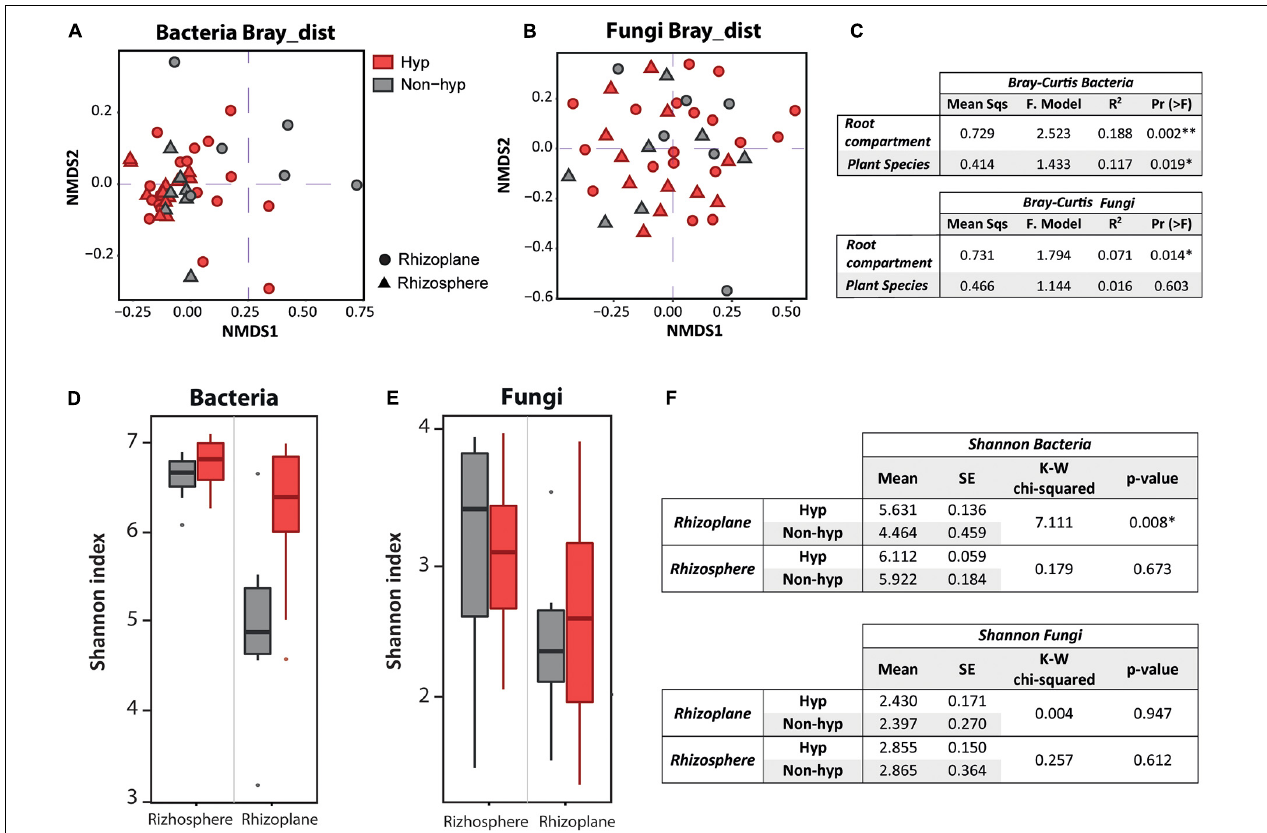
FIGURE 3 | Factors influencing the bacterial and fungal community and diversity. Non-metric multidimensional scaling visualization of the Bray–Curtis results of the bacterial domain (A) and fungal domain (B) . Plant species are differentiated by color (red is the hyperaccumulator; gray is the non-hyperaccumulator), and root compartments by shape (dots represent the rhizoplane; triangles represent the rhizosphere). (C) Summarized table of the PERMANOVA of the Bray–Curtis distances on the effect of root compartment and plant species for the bacterial and fungal domain, separately. (D) α Diversity boxplot of the bacterial domain. (E) α Diversity boxplot of the fungal domain. The Shannon index divided by root compartment and plant genotype. The x axis indicates root compartment, whereas plant genotype is differentiated by color (red is N. brachypetala ; gray represents non-hyperaccumulator species). (F) Summarized table of the Kruskal–Wallis analysis from the Shannon index on the effect of root compartment of the bacterial and also the fungal